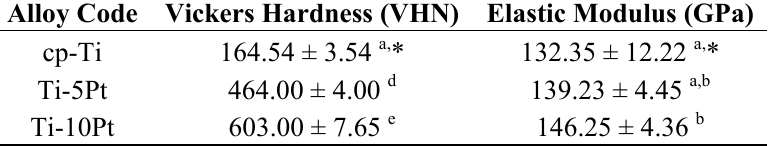
Table 1. Vickers hardness and elastic modulus values of Ti-xPt alloys compared with cp-Ti ( number of measurements =